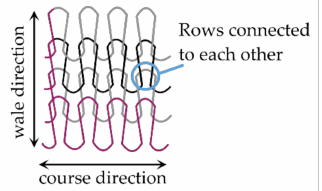
Figure 1. Knit structure consisting of interlinked rows of loops; current paths indicated in